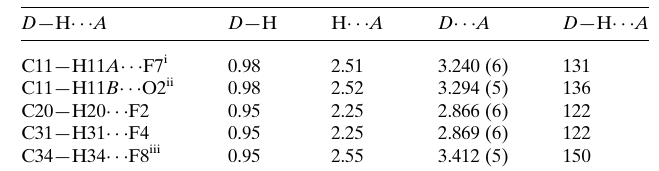
Table 1 Hydrogen-bond geometry (A˚ , (cid:2) ).